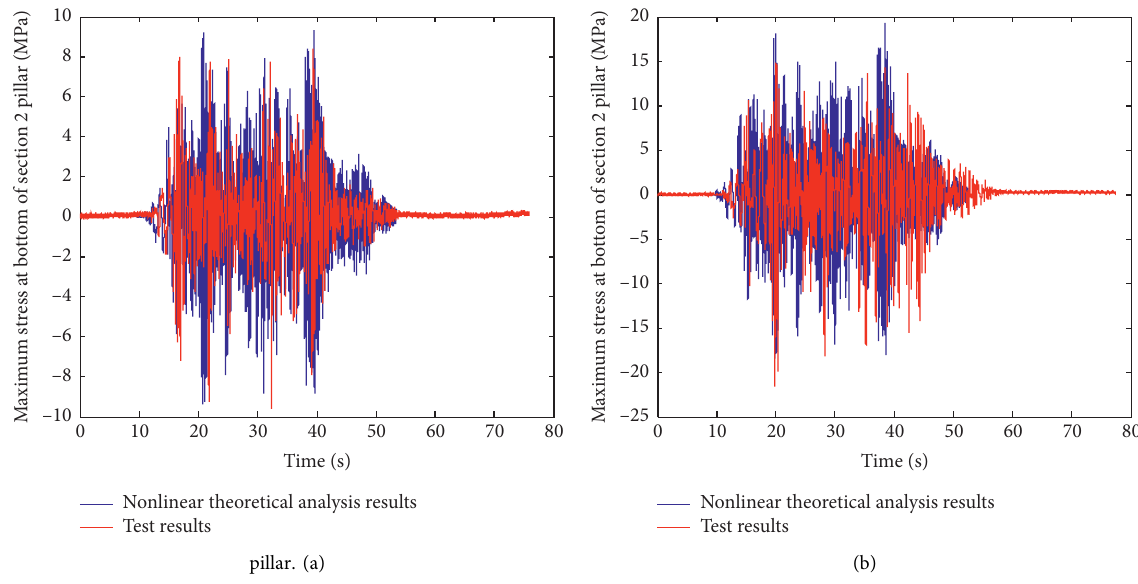
Figure 13: Comparative diagram of maximum stresses at the bottom of section 2 pillar. (a) 0.15g. (b)